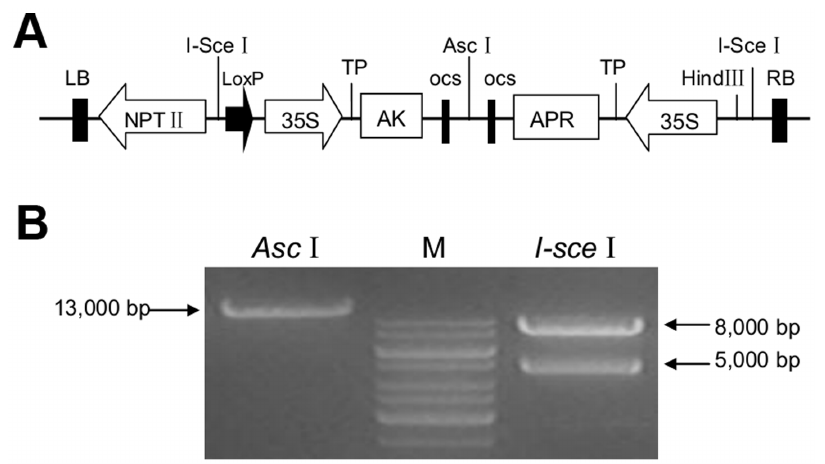
Figure 1. Construction and confirmation of pDESAK-APR. A. Schematic map of the T-DNA region of pDESAK-APR. The AK and APR genes were fused with the chloroplast transit peptide by restriction digest using Xho I and Xba I enzymes to construct the intermediate vectors pOSB108-AK and pOSB208-APR. In vivo Cre/loxP-mediated recombination via the loxP site to construct the co-expression vector pDESAK-APR. Hind III, Asc I and I-sce I: restriction endonuclease; NPT II: kanamycin resistance gene; 35S: cauliflower mosaic virus 35S promoter; TP: chloroplast transit peptide; OCS: octopine synthase terminater; LB and RB: left border and right border of the T-DNA. B. Enzyme digestion analysis of pDESAK-APR. Lane Asc I: Vector digested by Asc I and Lane I-sce I: Vector digested by I-sce I. Lane M: molecular mass marker is GeneRuler TM 1 kb DNA ladder (MBI Fermentas, MD, USA). Arrow on the left indicates the expected fragment of 13,000 bp, arrows on the right indicate the expected fragment of 5,000 bp and 8,000 bp.